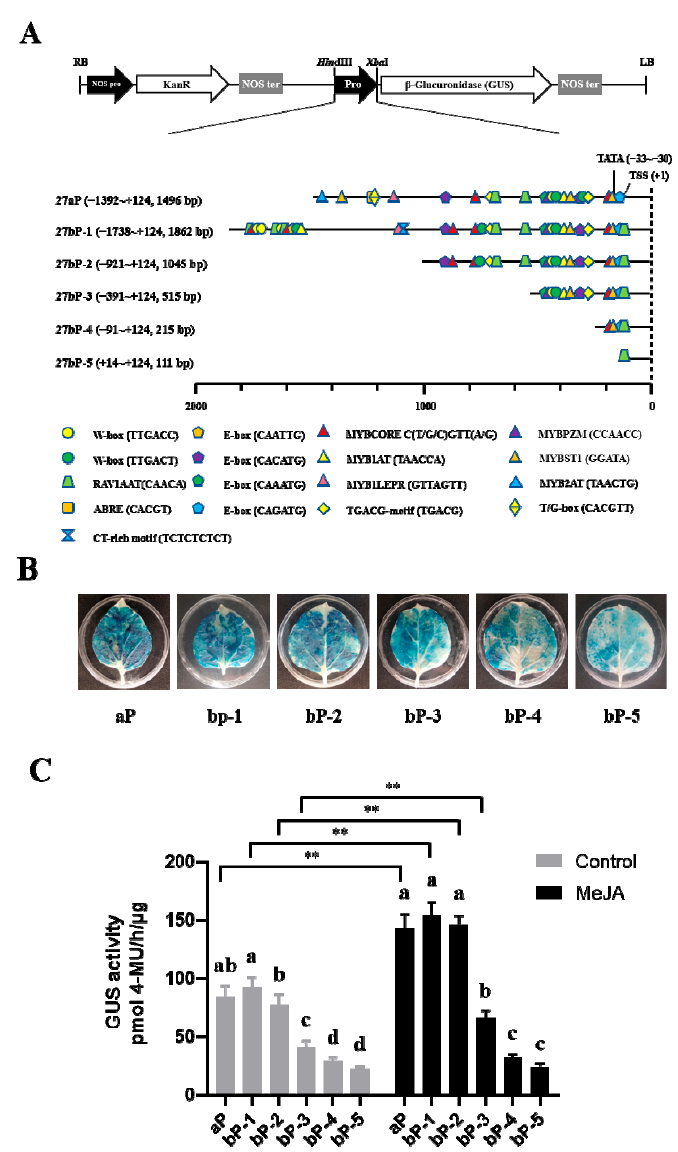
(cid:48) -deletion